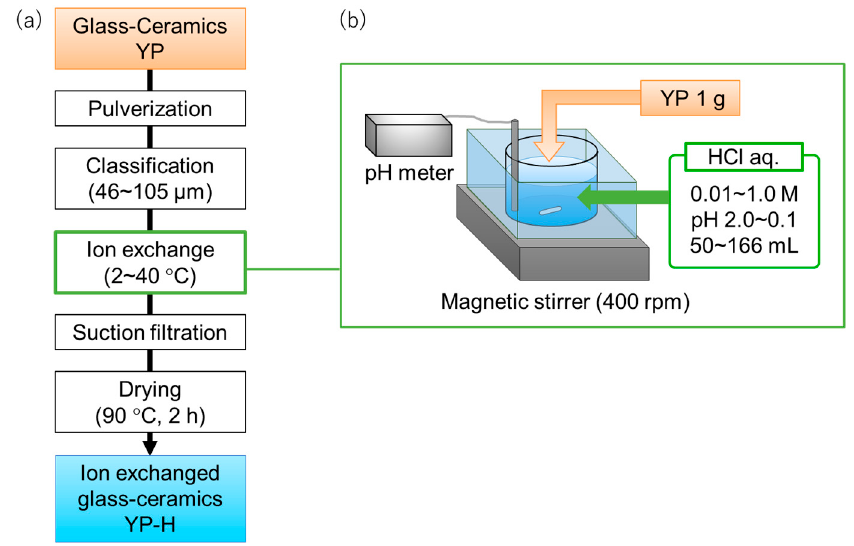
Figure 1. Flow diagram of materials preparation ( a ) and picture of ion exchange experiment ( b ).